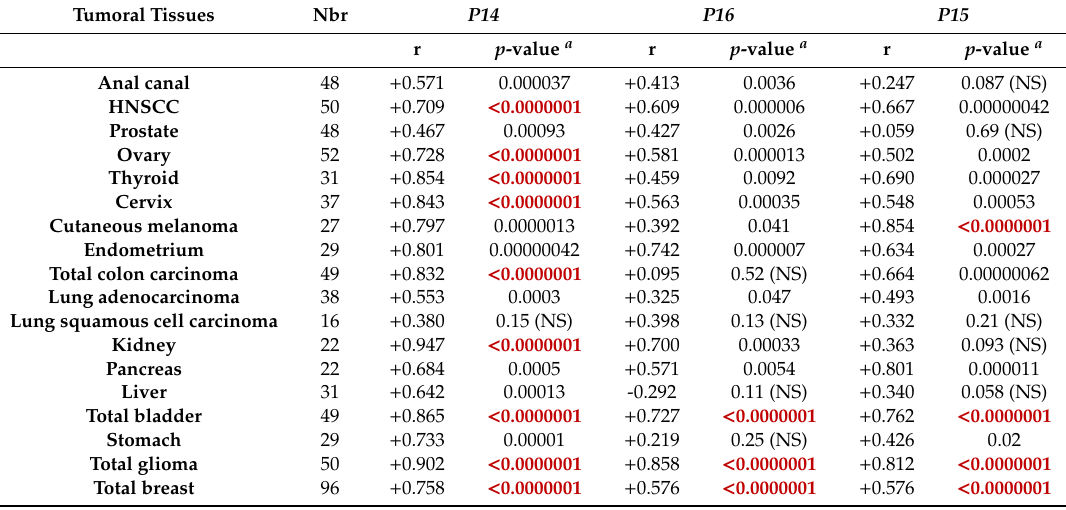
Table 2. Statistical analysis and correlation between ANRIL and P14 , P15 and P16 mRNA expression levels in the series of tumoral